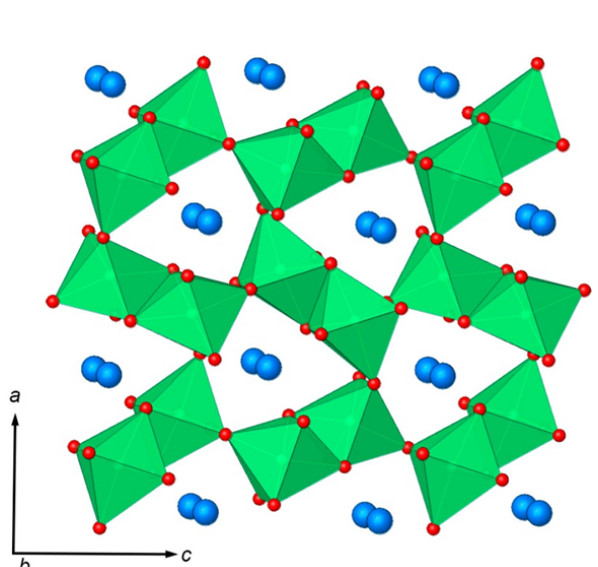
Figure 7. The crystal structure of ellinaite. A framework composed of edge- and corner-sharing [CrO 6 ] octahedra (green) contains the system of channels propagated along the b axis. The channels are occupied by calcium ions (blue